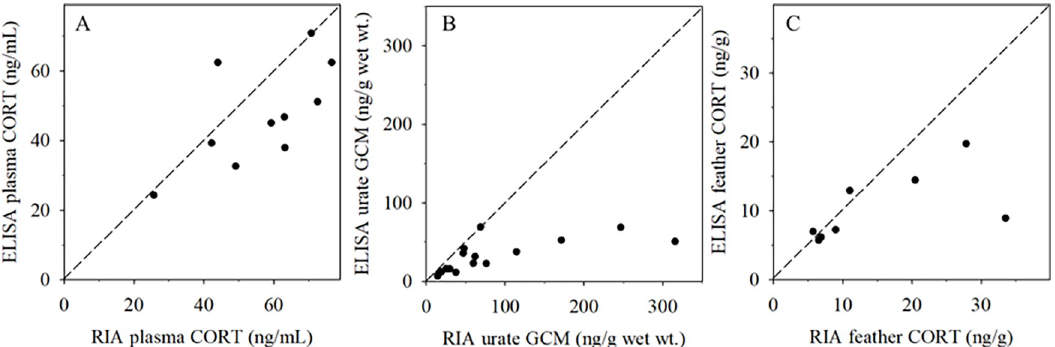
Fig 2. Measurements by radioimmunoassay (RIA) vs. enzyme-linked immunosorbent assay (ELISA) are different but significantly correlated for plasma corticosterone (CORT) and urate glucocorticoid metabolites (GCM). Each data point represents a condor sample measured by both RIA and ELISA. The dashed line indicates idealized agreement (y = x) between the RIA and ELISA values. In all sample types ELISA measurements trended lower than RIA measurements. (A) Plasma CORT concentrations by ELISA and RIA. (B) Urate GCM concentrations measured by RIA and ELISA, levels measured by ELISA are systematically lower by ~50%-600% compared to RIA. (C) Feather CORT concentrations measured by RIA and ELISA appear to agree only for lower CORT concentration samples ( < 12